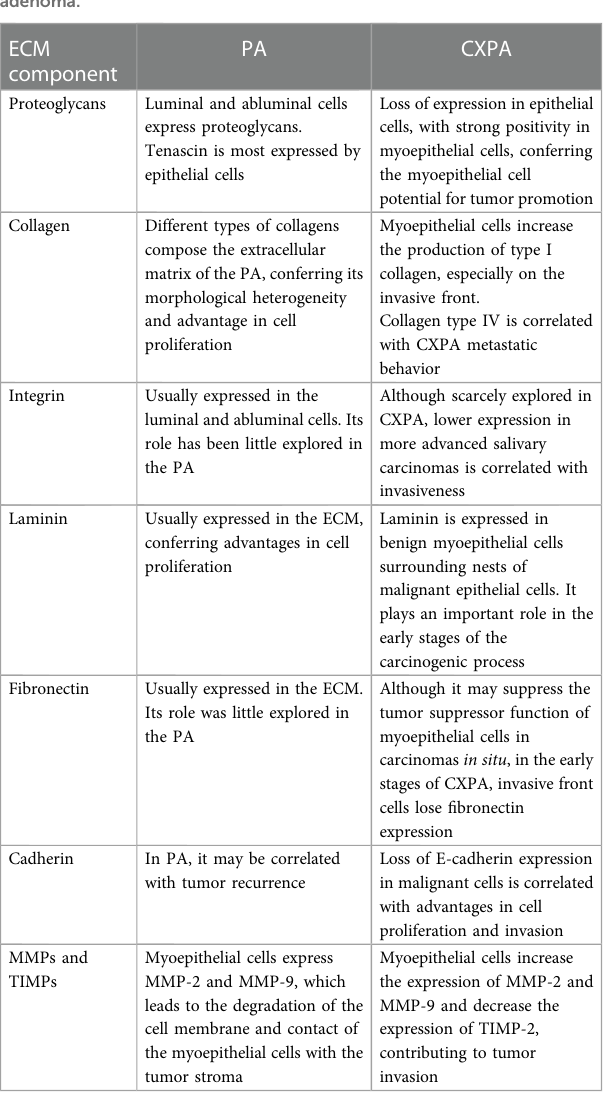
TABLE 1 Potential role of the ECM during the transition from PA to CXPA